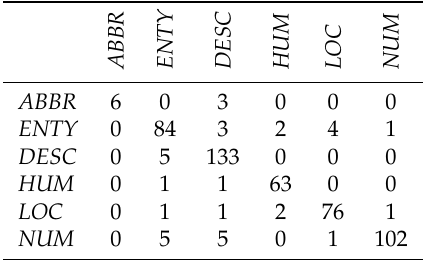
PureNN’s confusion matrices on Question Classification dataset (before human knowledge use).